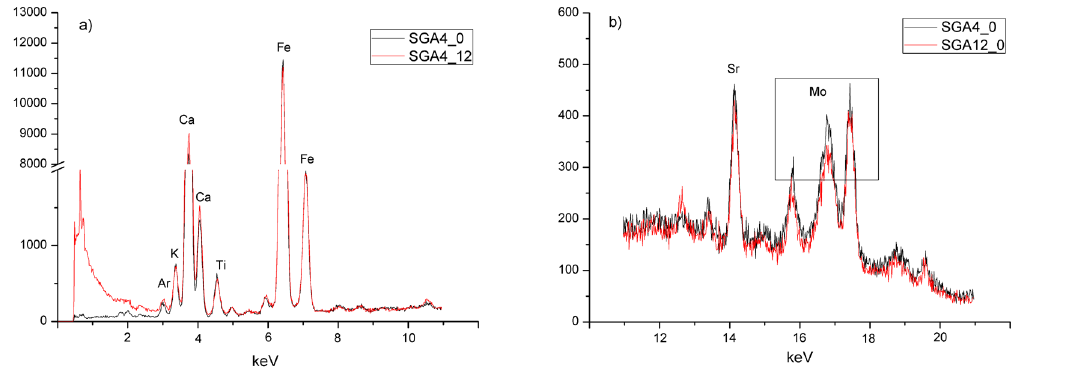
Figure 5. Comparison between the X-ray Fluorescence spectra of clays without firing and with firing at 900° C, SGA4_0 and SGA4_12. The three peaks in the high energy region come, in order of decreasing energy, from Rayleigh diffusion, Compton scattering and escape peak of anode Mo.